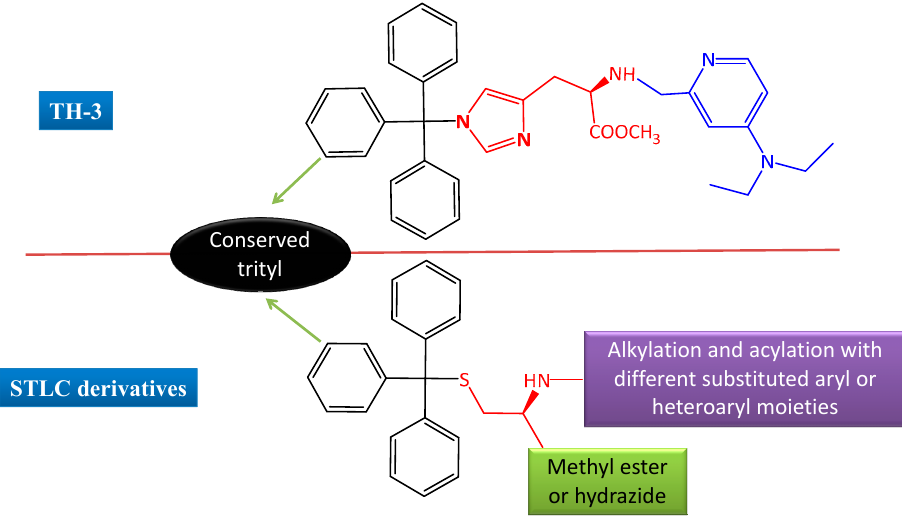
Figure 1. ( A ) S -trityl- l -cysteine (STLC) structure. ( B ) Binding interactions of STLC (green, PDB